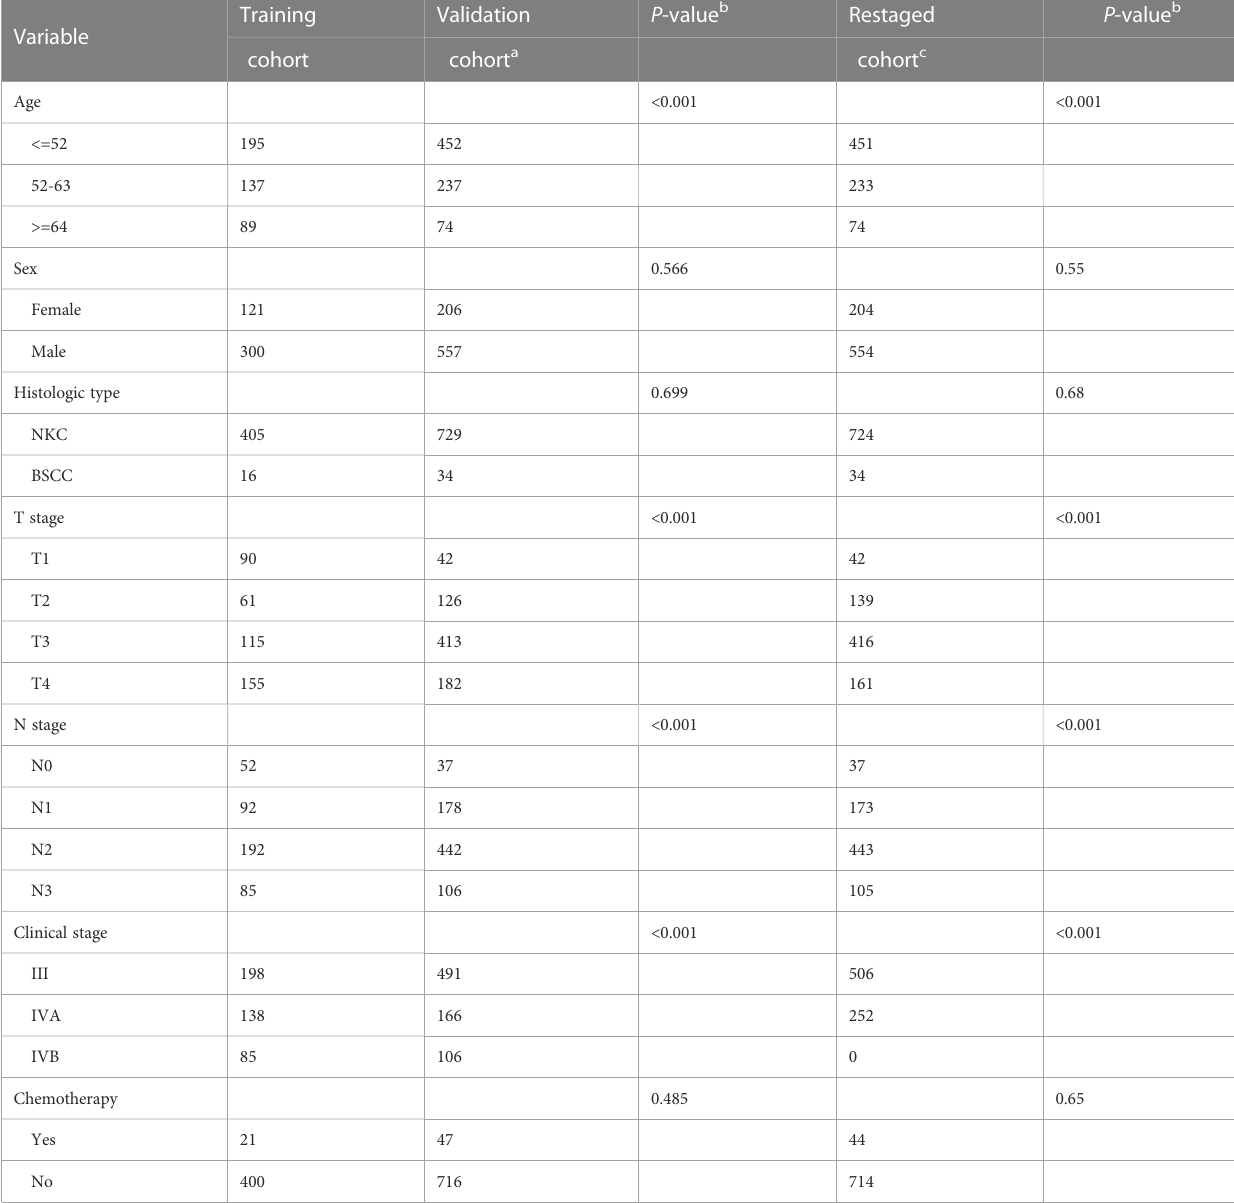
TABLE 1 Clinicopathologic characteristics of the LA-NPC patients in the training and validation